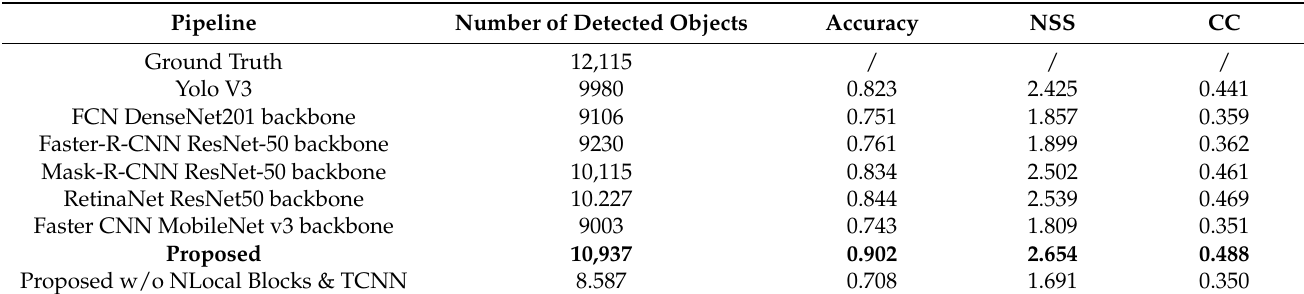
Table 2. Benchmark comparison with low-light